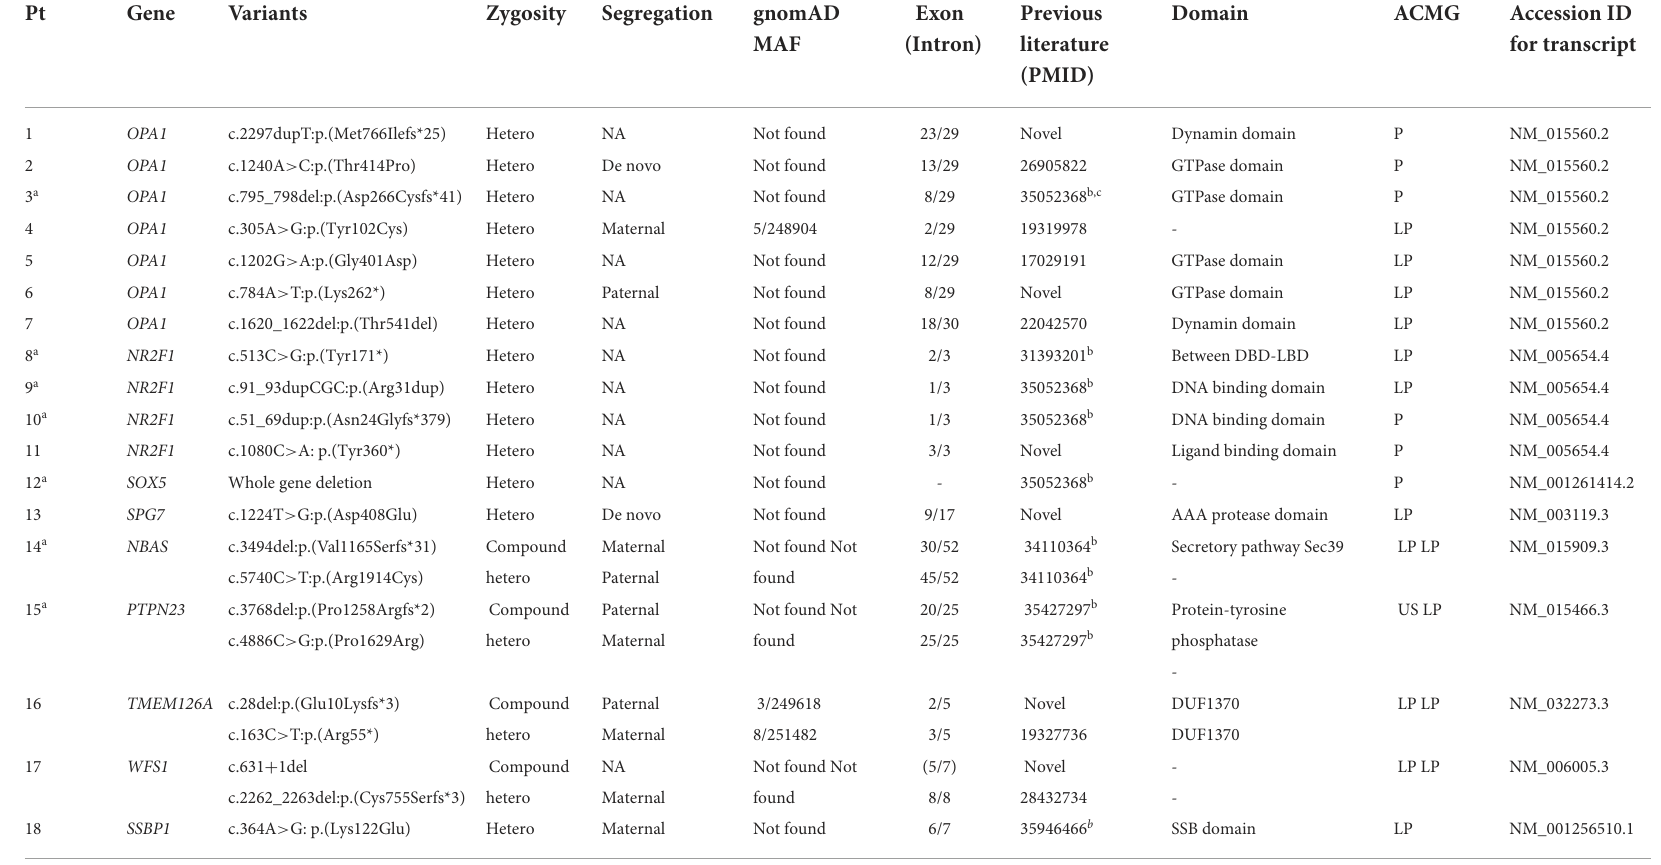
TABLE 2 Likely causative variants identified in patients with hereditary optic